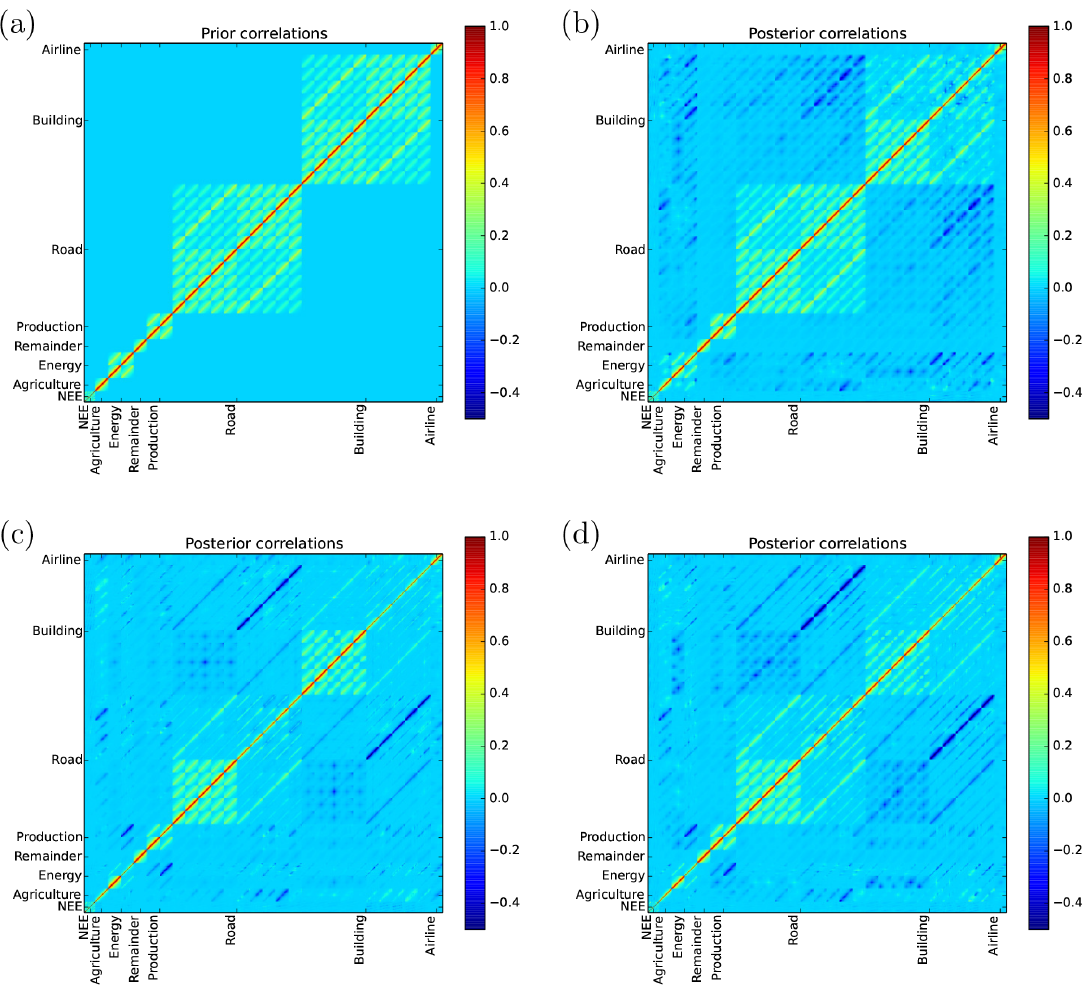
Figure 8. The correlation structures in (a) the error of prior scaling factor estimates, (b) the posterior error obtained by inversion using a U network with 10 stations, (c) the posterior error obtained by inversion using an E network with 70 stations, and (d) the posterior error obtained by inversion using a U network with 70 stations. Each row or column of the pixels corresponds to the correlation between 1 scaling factor and all the 834 scaling factors (see Sect. 2.2). For clarity, we group these scaling factors into eight sectors and organize them for each sector according to temporal indices and spatial areas. The tickers show the name of these eight